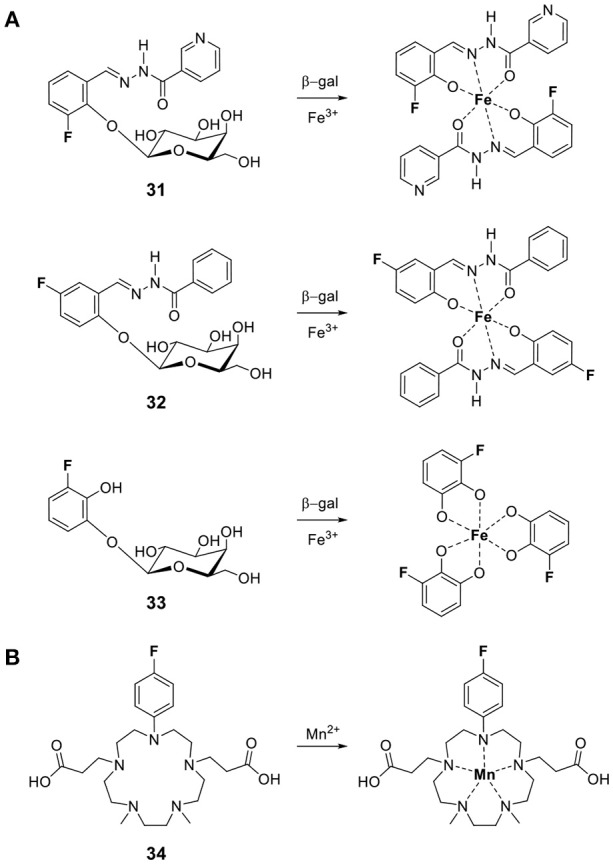
Responsive fluorine probes whose signals are modulated via the paramagnetic relaxation enhancement effect upon complexation of (A) FeIII following cleavage by β-galactosidase (31, Yu et al., 2012; 32–33, Yu et al., 2013b) or (B) MnII ions (34, Sarkar et al., 2017).